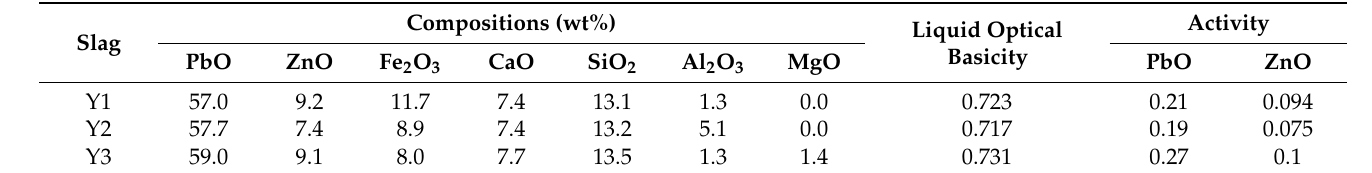
Table 7. The compositions and activities of the liquid slags at 1473 K are calculated by FactSage; the liquid optical basicity is calculated from liquid compositions and the data in Table 1.